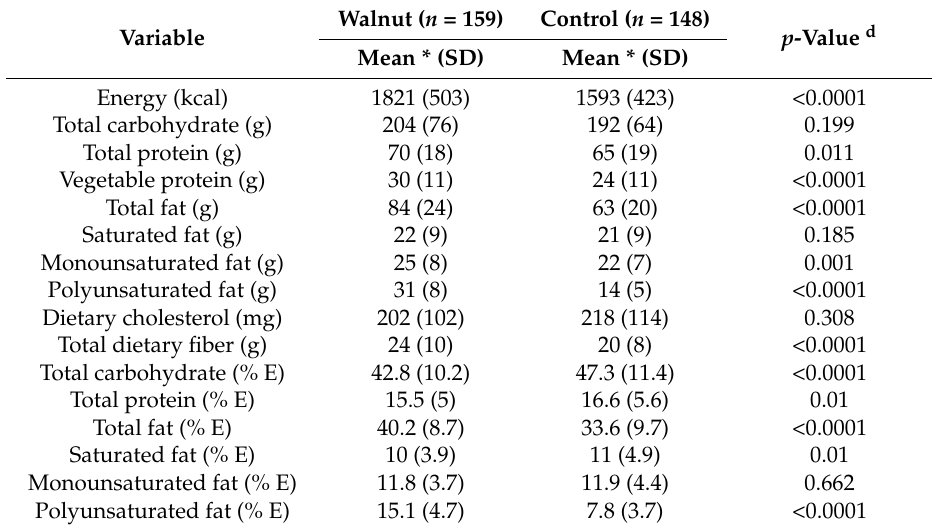
Table 2. Average daily intake of macronutrients at 2 years by intervention group in participants completing the